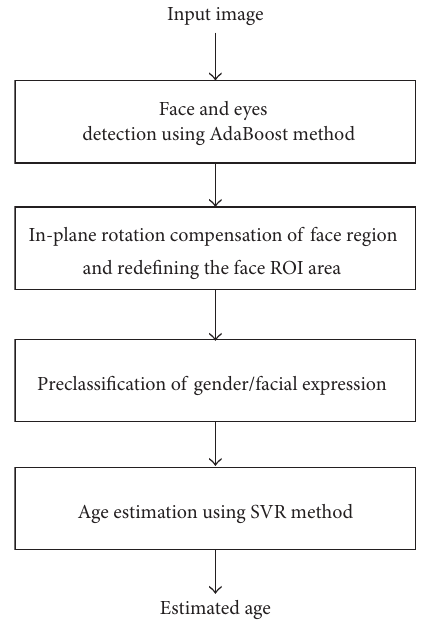
Figure 1: Overview of an age estimation system that considers the effects of gender and facial